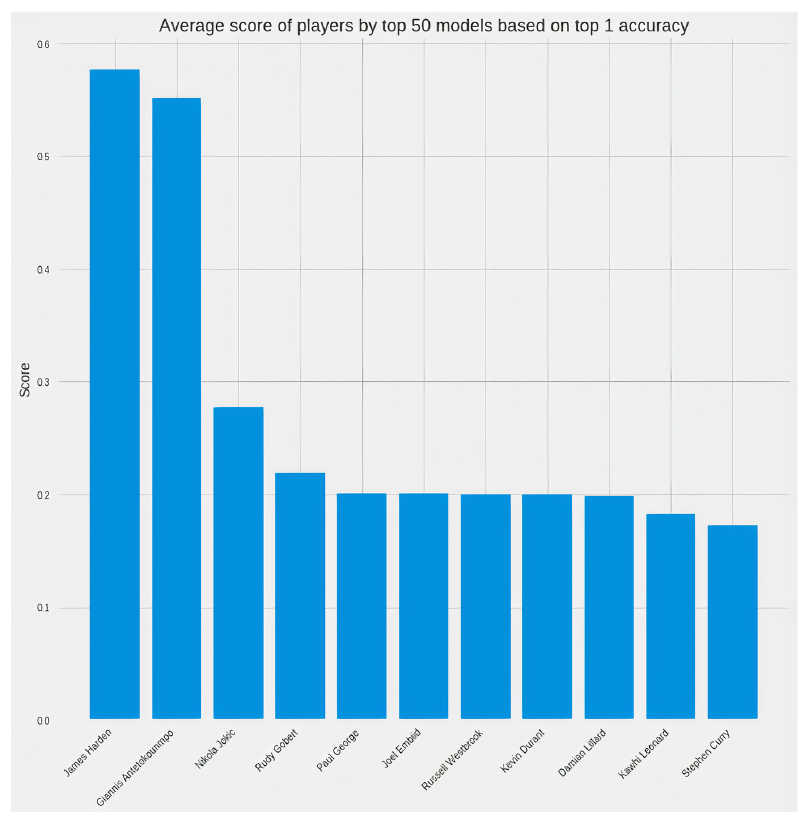
Figure 2. Fifty models’ average scores of candidate players.